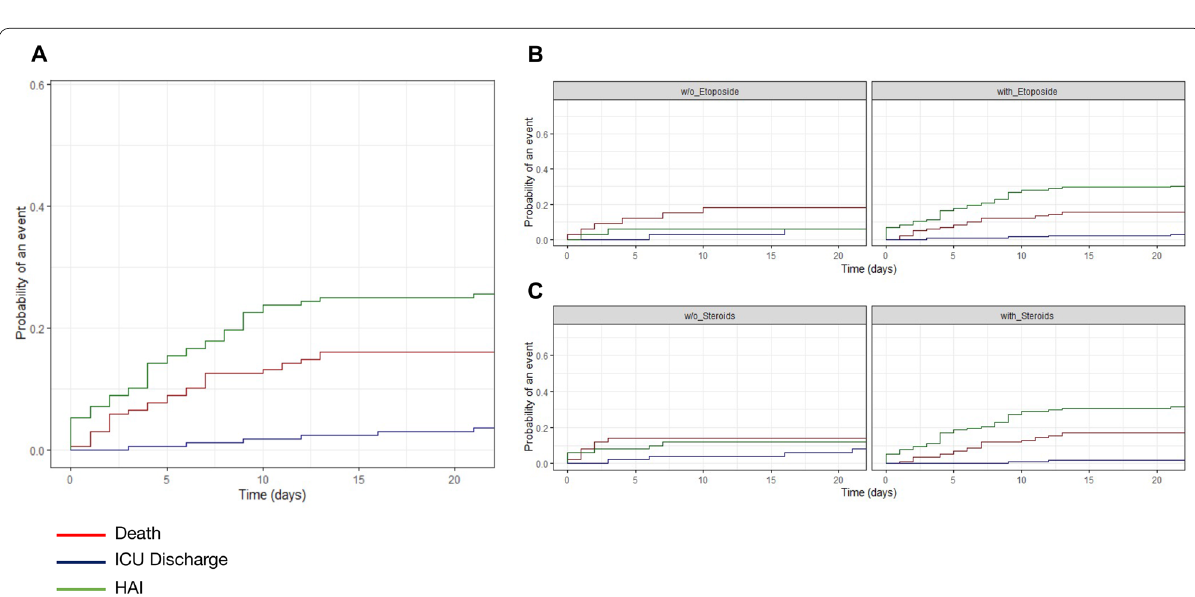
Fig. 2 Cumulative incidence functions (CIF) of competing events: HAIs in the ICU, ICU death and ICU discharge: A unstratified and stratified according to etoposide ( B) and steroids ( C ) treatment